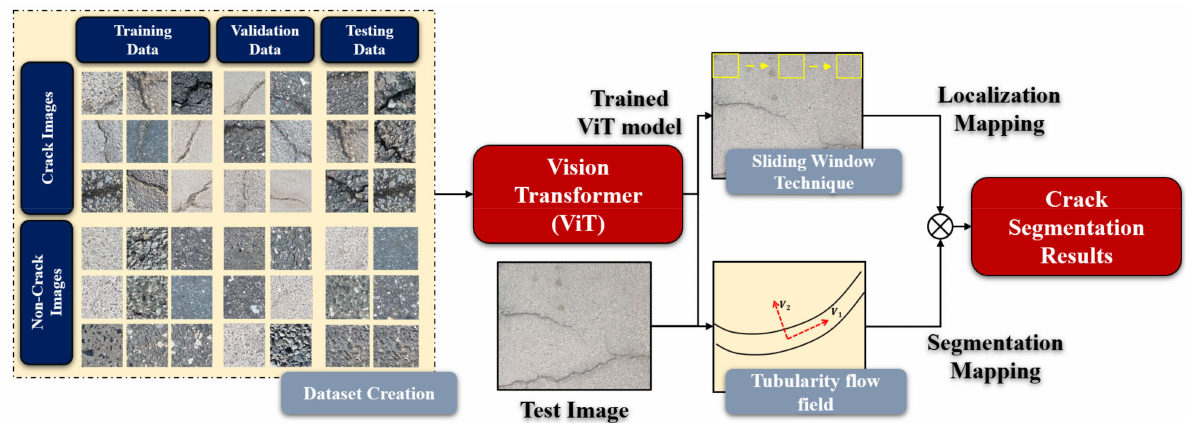
Figure 1. Overview of the proposed